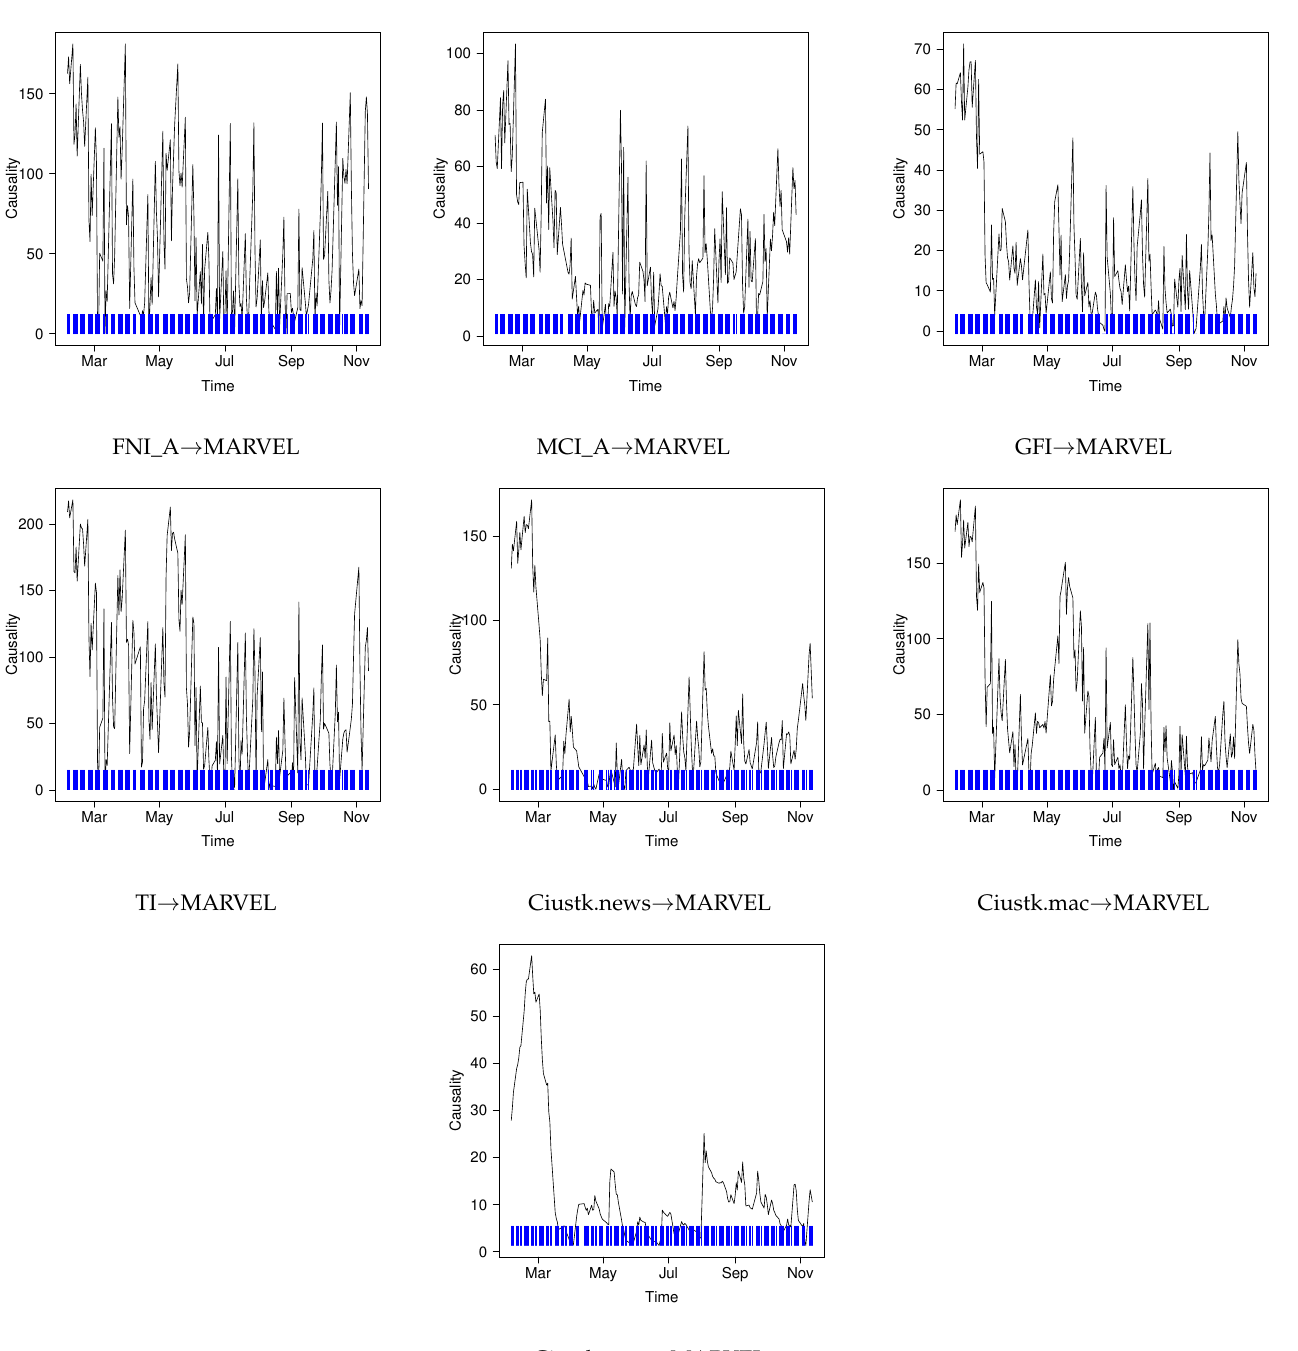
Ciustk.cmp → MARVEL Figure 6. Instantaneous, one-way Granger-causality from news series to MARVEL (DCC- GARCH